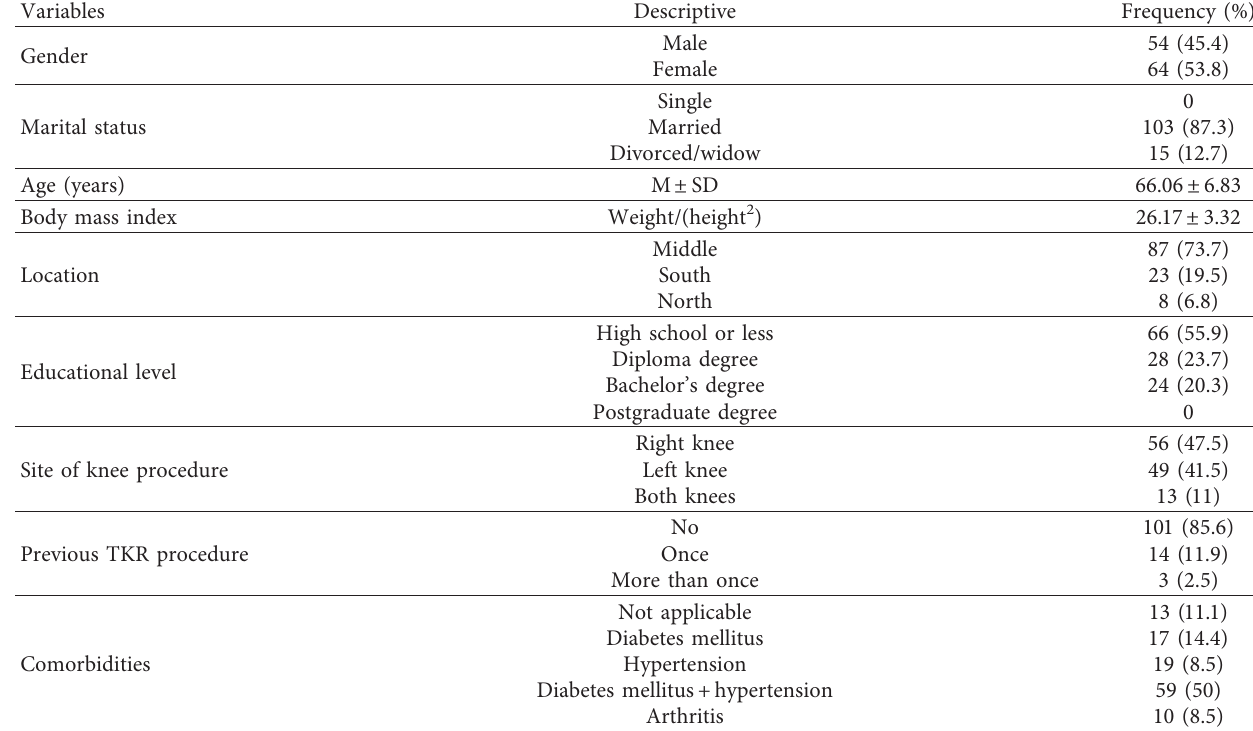
Table 2: Patients’ demographics ( N � 118).